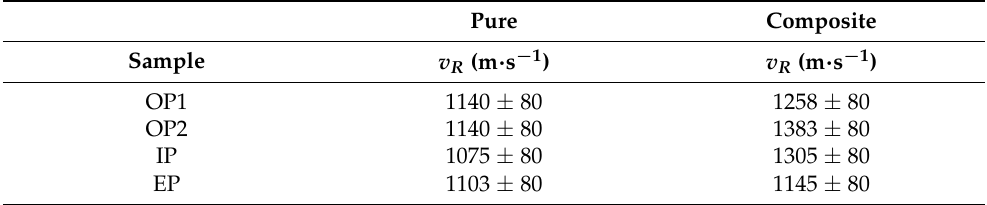
Figure 2. Spatio − temporal matrix obtained from monitoring of Rayleigh wave propagation in the OP2 sample ( above ). For x = 1 cm, the signal (blue) and its envelope (red) are shown ( below ). Table 5. Summary of Rayleigh wave velocity v R of the different